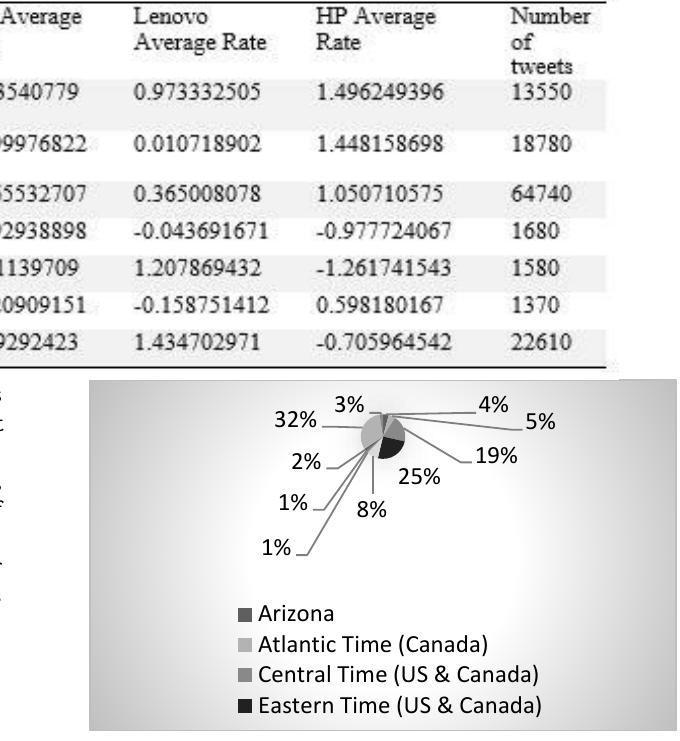
Figure 3. Percentage of Tweets in Each Region